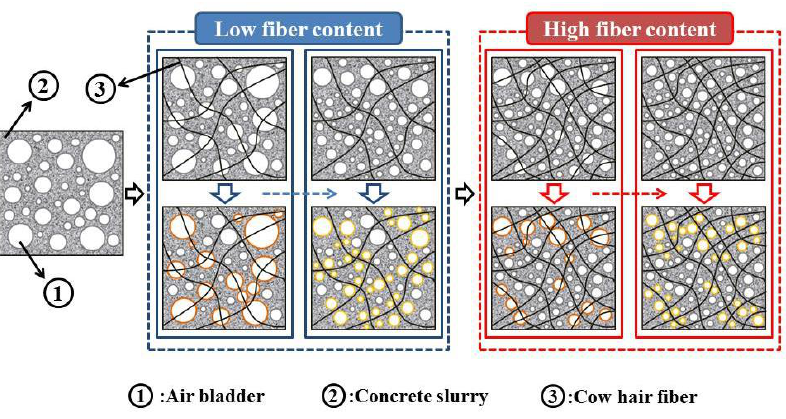
Figure 6. The mechanism of CHF affects the pore structure of foamed concrete.